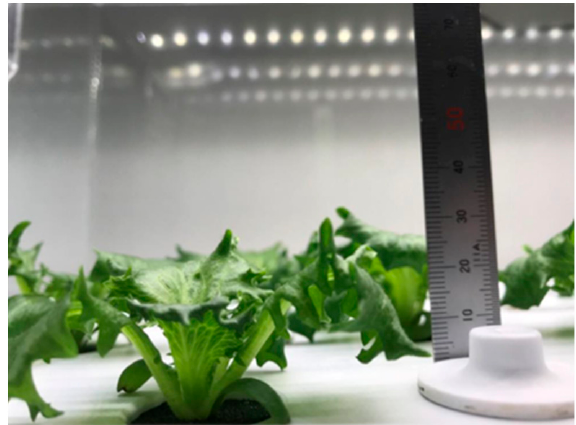
Figure 1. Lettuce on day 21 (the day of experiments). Lettuce seeds were germinated and grown on sponge-like foamed urethane cuboids steeped in liquid fertilizer in a plastic tray, then moved to a hydroponic cultivator on day 5, which was placed in a room at 20 °C with a relative humidity of 50–80%. Plants were established at 20 °C day/night temperatures with 50–80% relative humidity with a light–dark cycle of 16 h (light) and 8 h (dark) for 21 days.